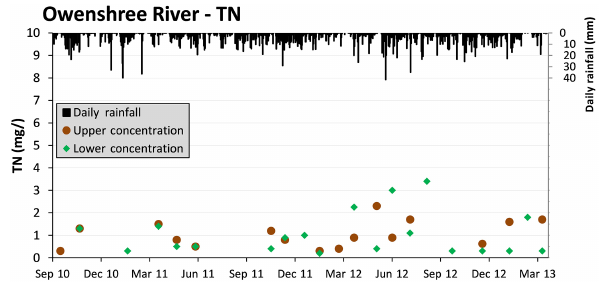
Figure 6. Daily rainfall and TP concentrations at the upper (U) and lower (L) sampling locations on the SA1